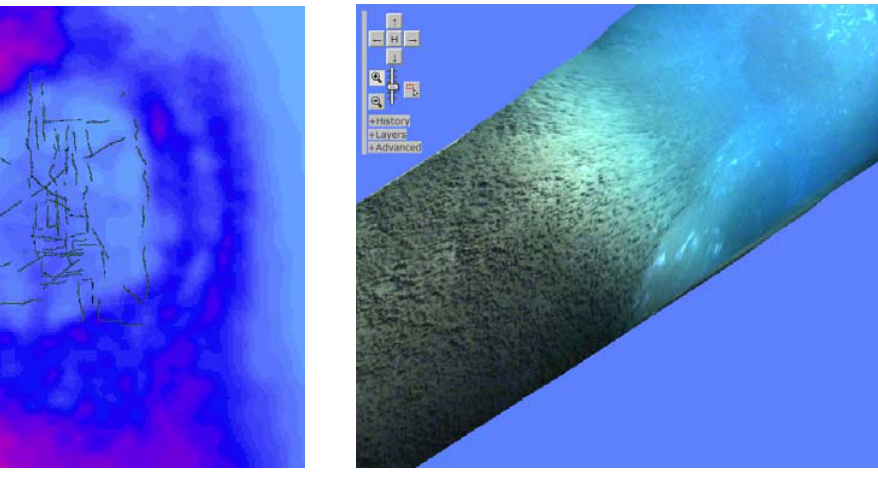
Figure 3. Overview of the Håkon-Mosby Seafloor Mud Volcano (left) and detail zoom (right), obtained as EarthLook screenshots (data acquired on AWI Polarstern cruise ArcXIX3b